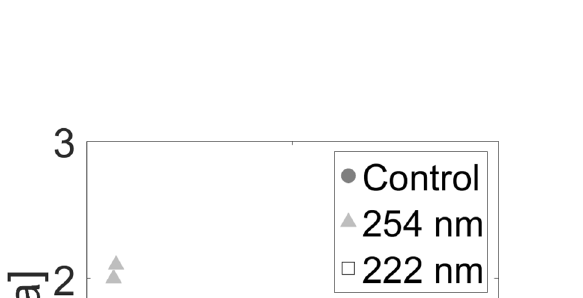
Figure 7. UVC light induces changes in the mechanical properties of SC equilibrated to 100% RH. Average ( A ) elastic modulus, E , ( B ) fracture stress, σ f , ( C ) fracture strain, γ f , and ( D ) work of fracture, W f for unirradiated controls (Control; light grey), 254 nm irradiated samples (dosage range: 50–200 J/cm 2 ; dark grey), and 222 nm irradiated samples (dosage range: 50–200 J/cm 2 ; white). Bars denote average values of 4 ≤ n ≤ 5 individual sample measurements for each range and dosage condition. Error bars denote standard deviations. Confidence intervals are indicated by * p ≤ 0.05, ** p ≤ 0.01, *** p ≤ 0.001.